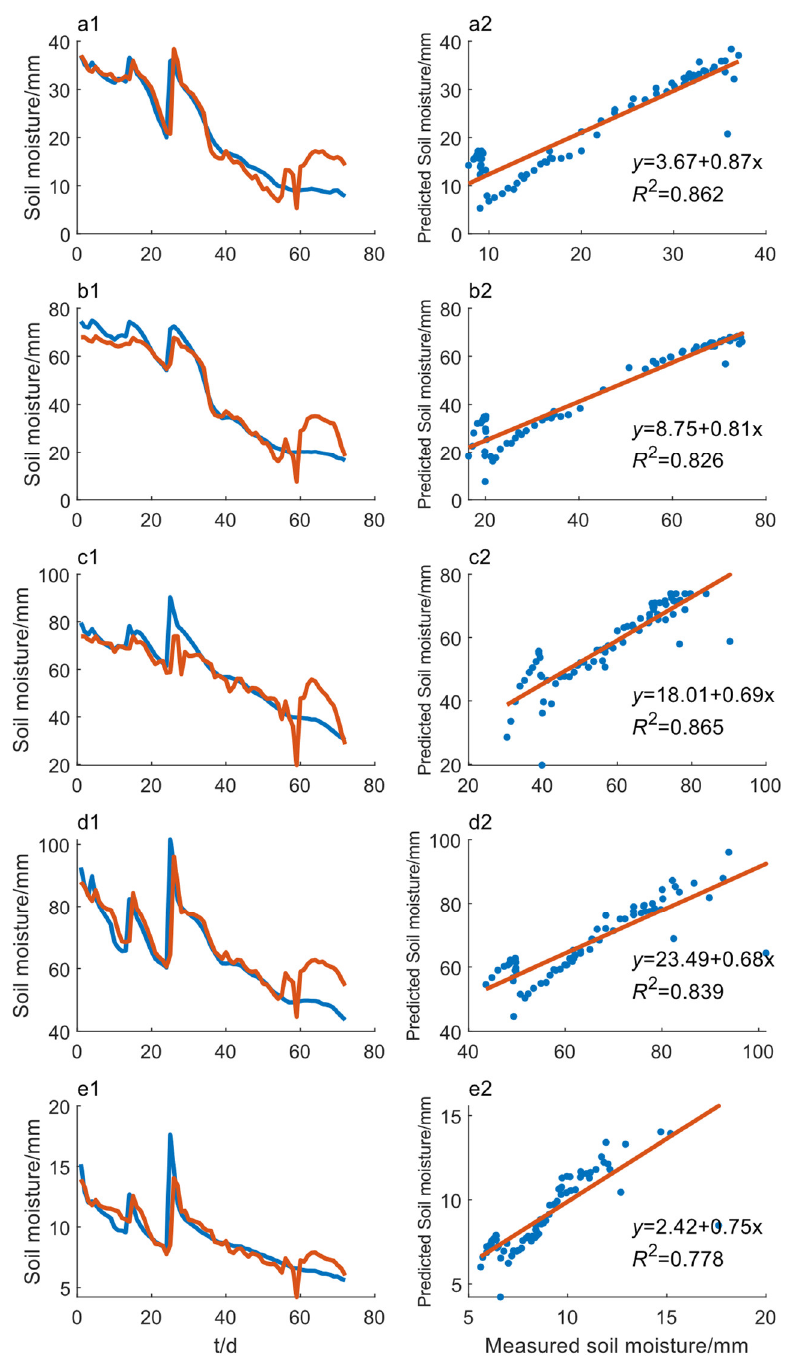
Figure 15. Comparison of the MLNN model in different datasets for SM. ( a – e ) represent node 1–5, respectively; in ( a1 – e1 ), the blue line represents the measured SEC, and the orange line represents the predicted SEC; ( a2 – e2 ) represents the regression fitting between the predicted SEC and measured SEC.